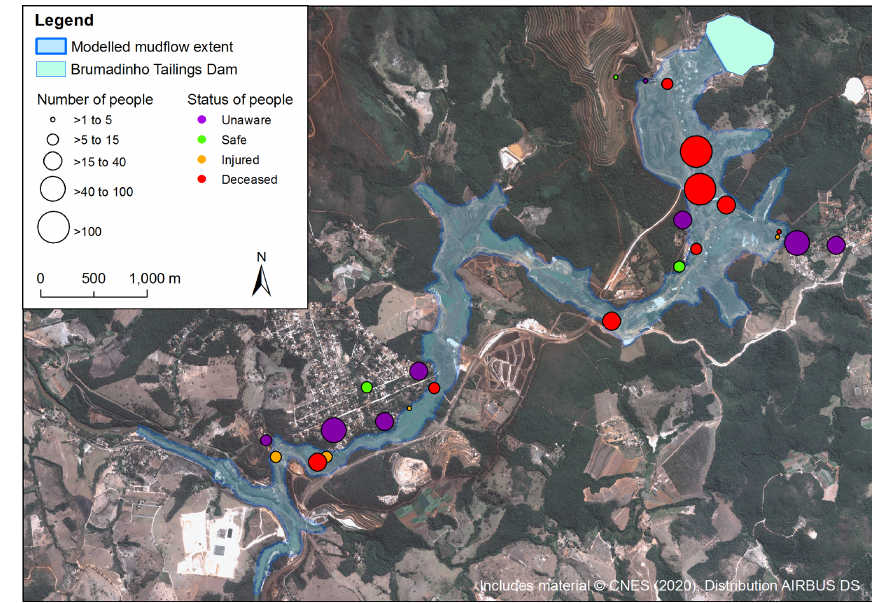
Figure 11. Results of the LSM modelling showing the distribution of modelled fatalities for the January 2019 incident. Table 3. Results of the Life Safety Model (LSM). Estimated number of Estimated number of fatalities with people fatalities with people escaping on foot and escaping on foot only in vehicles Mining Villages Total Mining Villages Total Scenario modelled site